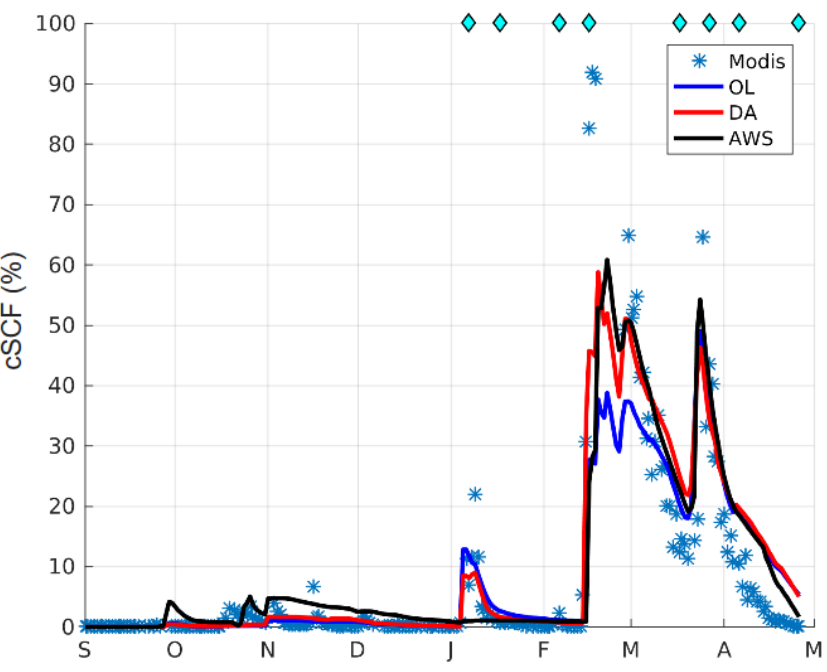
Figure 9. Comparison of the simulated and observed snow covered fraction of the Rheraya catchment (cSCF) at the daily time step. The blue diamonds in the upper part of the figure indicate the date of the assimilated Sentinel-2 observations. OL: open loop sSCF, DA: data assimilation sSCF, AWS: modeled sSCF by using automatic weather stations